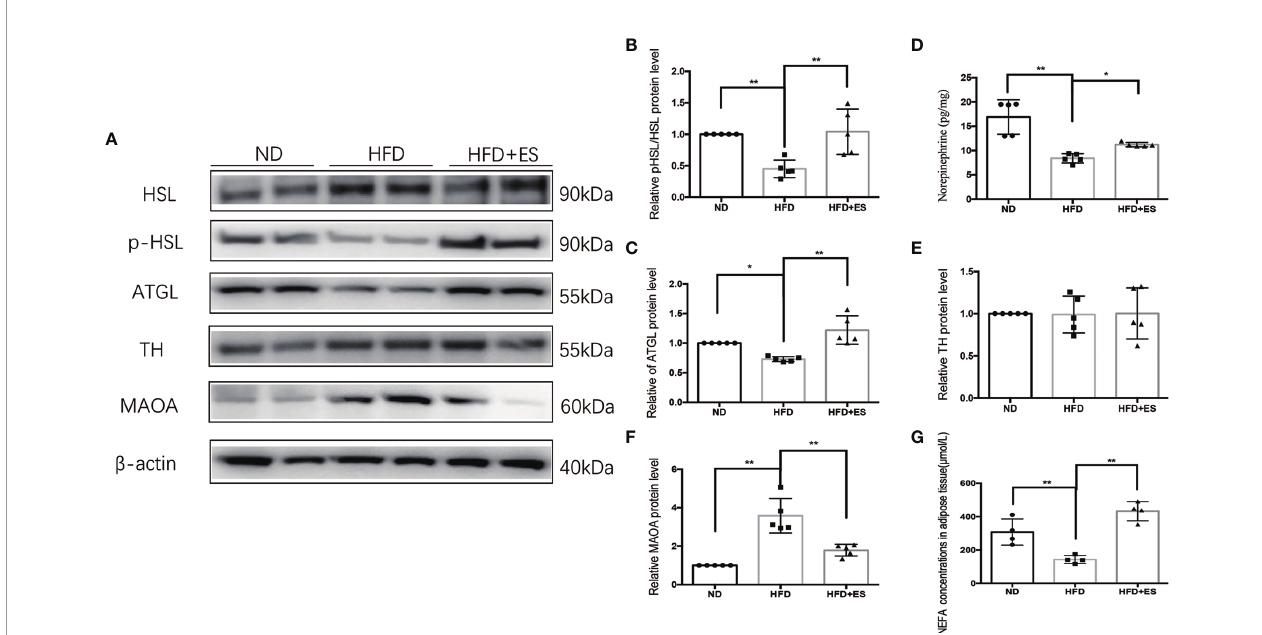
FIGURE 3 | ES induced lipolysis by attenuating the activation of MAOA in eWAT. (A) Immunoblot image showing ATGL, HSL, p-HSL, TH, and MAOA in the ND, HFD, and HFD+ES groups. (B) Relative p-HSL/HSL protein expression in eWAT (n = 5, ** P < 0.01). (C) Relative ATGL protein expression in eWAT (n = 5, * P < 0.05,